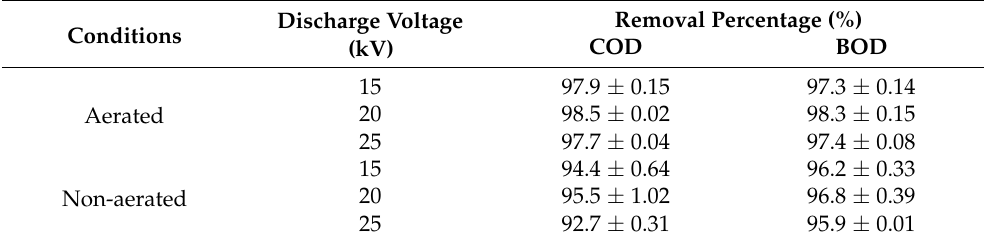
Figure 4. Changes in COD and BOD after DBD treatment under aerated and non-aerated conditions at different discharge voltages of 15, 20, and 25 kV. The different letters (a–f) indicate that the observed differences are statistically significant at p < 0.05. Table 4. The removal percentage of COD and BOD in DBD treatment under aerated and non-aerated conditions at different discharge voltages. The values are shown in mean with standard